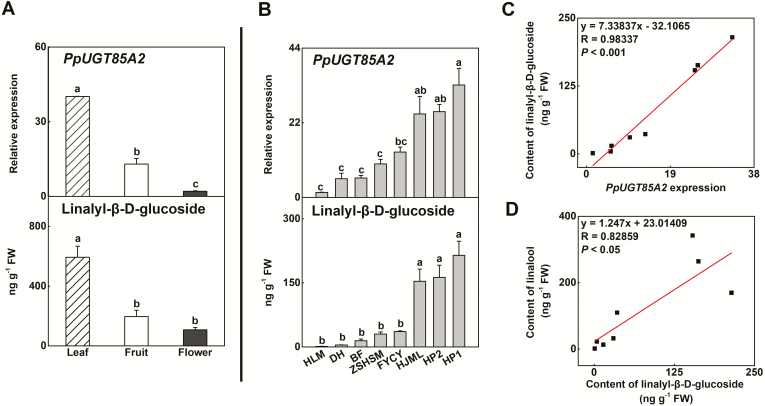
Expression of PpUGT85A2 and content of linalyl-β-d-glucoside in peach. (A) Expression of PpUGT85A2 and content of linalyl-β-d-glucoside in peach young leaf, open flower, and ripe fruit at 111 DAB. (B) Expression of PpUGT85A2 and content of linalyl-β-d-glucoside in ripe fruit of eight peach cultivars. (C) Correlation between PpUGT85A2 expression and linalyl-β-d-glucoside content in ripe fruit of eight peach cultivars. (D) Correlation between linalyl-β-d-glucoside and linalool content in ripe fruit of eight peach cultivars. Data are presented as the mean ±SE from three independent biological replicates. Values labeled with different letters indicate a significant difference at P<0.05.